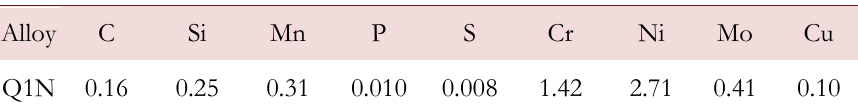
Table 1: Chemical composition in weight % of Q1N steel. The balance is Fe.